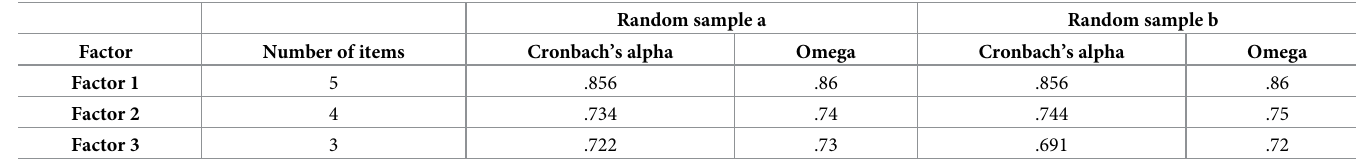
Table 3. Results of Cronbach’s alpha reliability and Omega—CRS-Y Scale (random sample a; n = 1828) (random sample b; n =